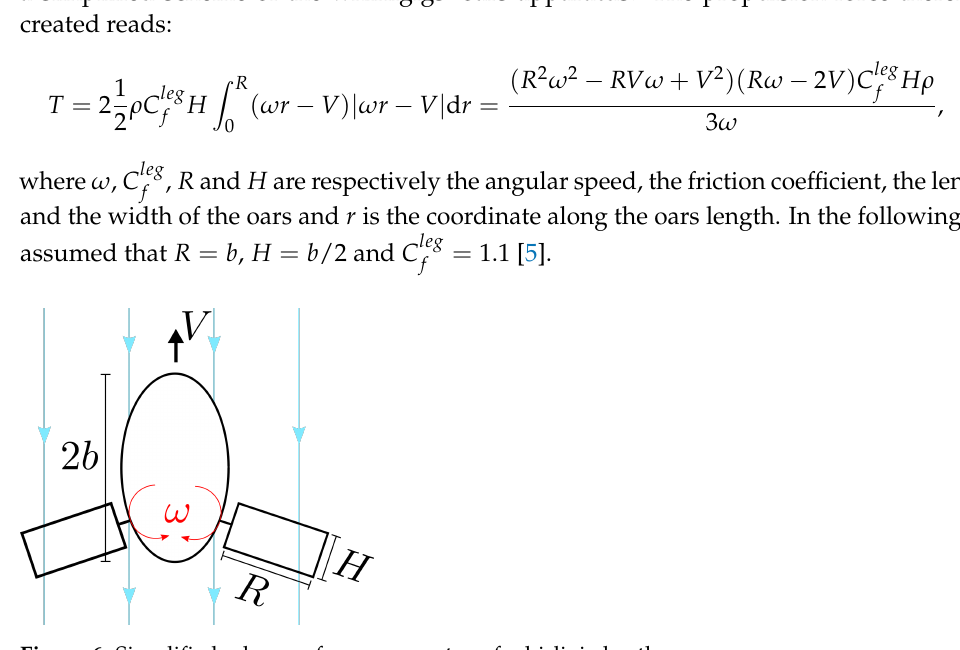
Figure 6. Simplified scheme of oars apparatus of whirligig